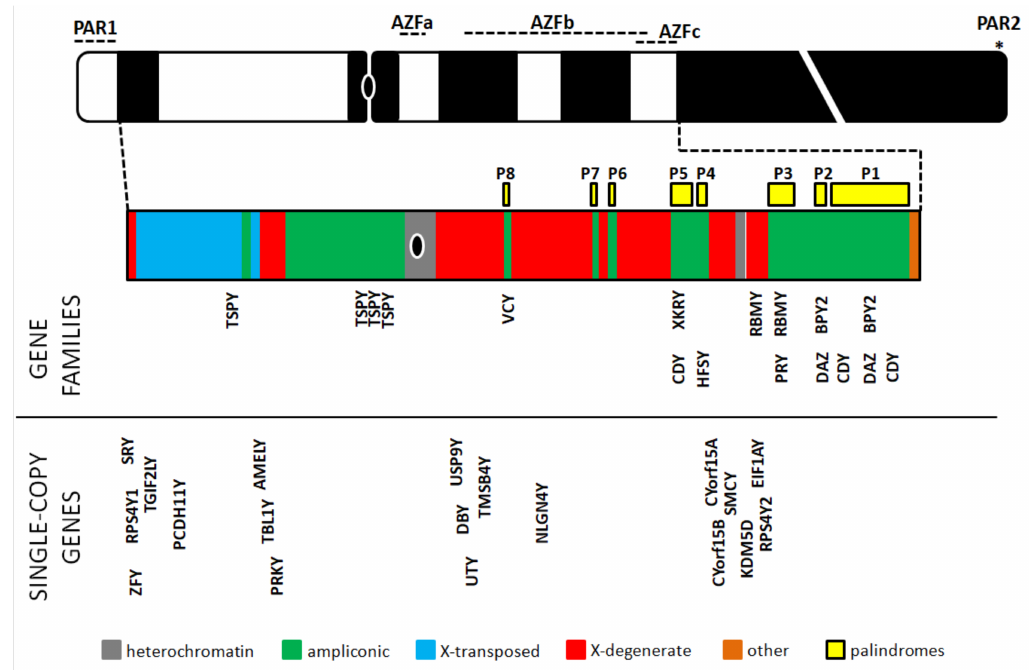
Figure 2. Organization of the euchromatic portion of the MSY region (MSYe). The picture also reports the localization of the palindromic regions P1–P8 and, for comparison with Figure 1, also PARs and AZF regions. The black oval indicates the centromere. The region q12 is shortened (white cut), due to its large extension compared to the rest of the chromosome. The colored MSYe region is slightly enlarged compared to the Y chromosome (grey lines) to enhance the readability. Gene families and single-copy genes are reported according to [128], with minor